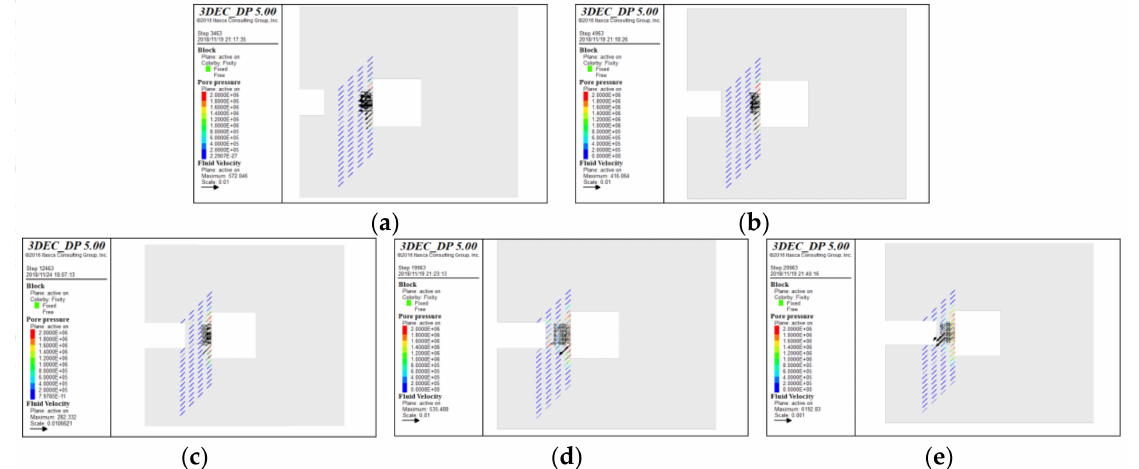
Figure 11. Water inrush pathway evolution in water-resistant strata ahead of karst tunnel face in excavation process. ( a ) Calculation step = 3463; ( b ) Calculation step = 4963; ( c ) Calculation step = 12,463; ( d ) Calculation step = 19,963; ( e ) Calculation step =